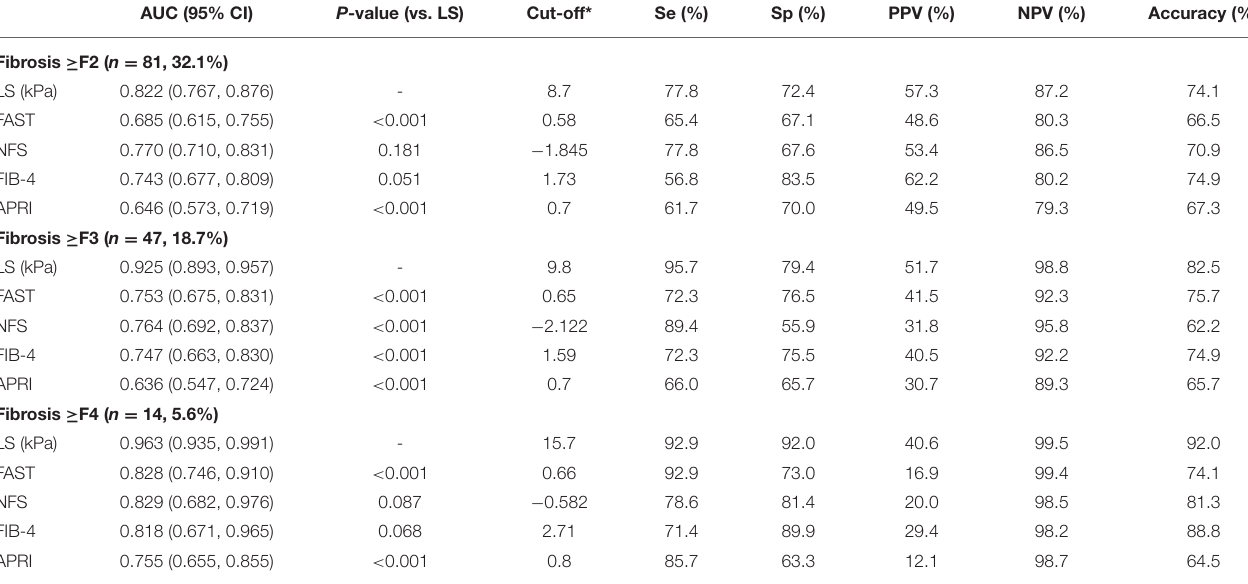
TABLE 3 | Comparisons between non-invasive fibrosis surrogates for predicting histologic fibrosis stage. AUC (95% CI) P -value (vs. LS) Cut-off* Se (%) Sp (%) PPV (%) NPV